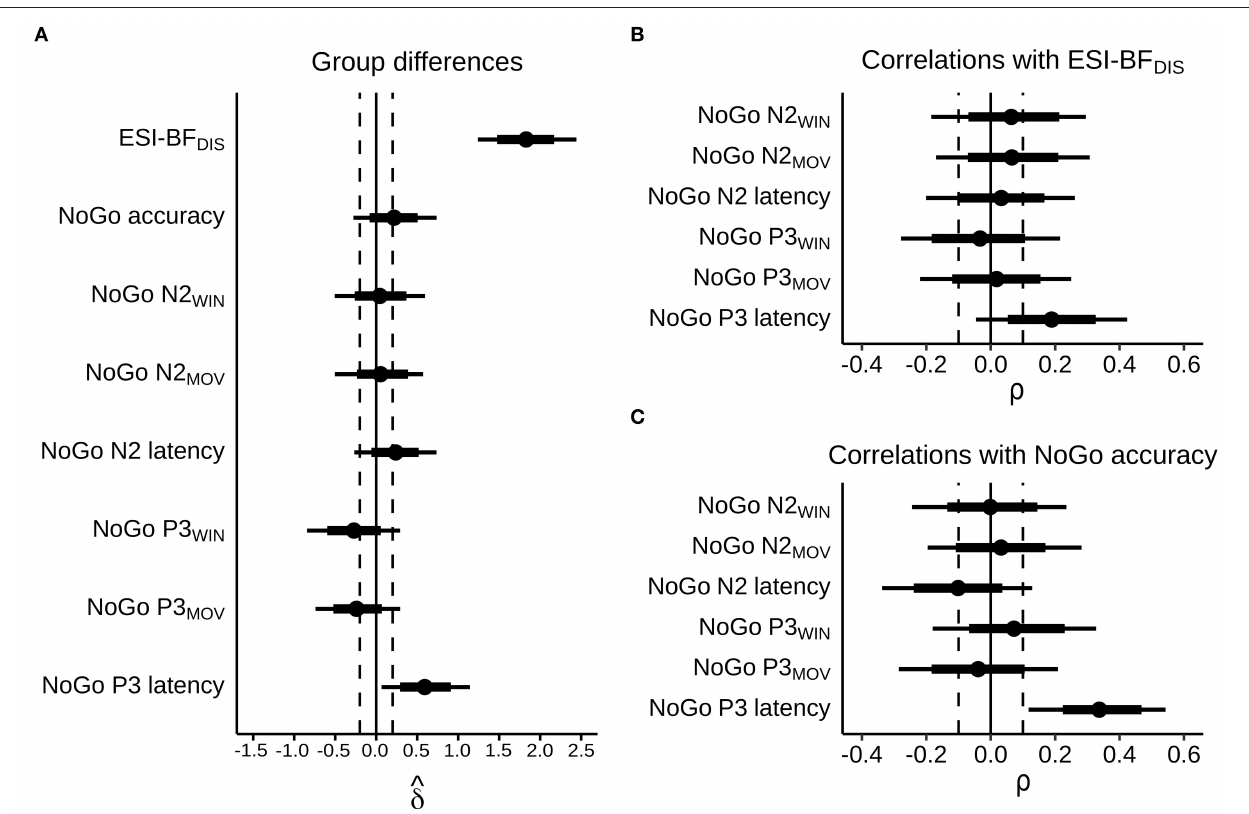
FIGURE 4 | Posterior estimates, with dots representing posterior medians, thick bars representing 66% highest density intervals, and narrow bars representing 90% highest density intervals. Dashed lines indicate cutoffs for “small” effect sizes, corresponding to absolute values of ˆ δ = 0.2 and ρ = 0.1. (A) Estimated bias-corrected standardized group differences, MDOs relative to controls. (B) Estimated correlations with self-reported trait disinhibition in the whole sample. (C) Estimated correlations with NoGo accuracy in the whole sample.